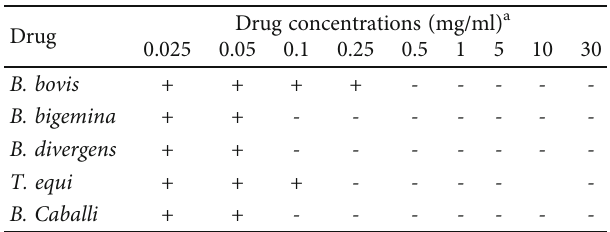
Figure 1: Inhibitory e ff ect of pomegranate ( Punica granatum ) peel on B. bovis , B. bigemina , B. divergens , T. equi , and B. caballi on the fourth day of treatment. Each value represents the mean of triplicate trials after subtraction of the background fl uorescence for nonparasitized RBCs. Asterisks denote a signi fi cant di ff erence between the pomegranate ( Punica granatum ) peel-treated and control cultures ( P < 0 : 05 ). Table 2: Viability test results of pomegranate ( Punica granatum ) peel evaluated for Babesia and Theileria